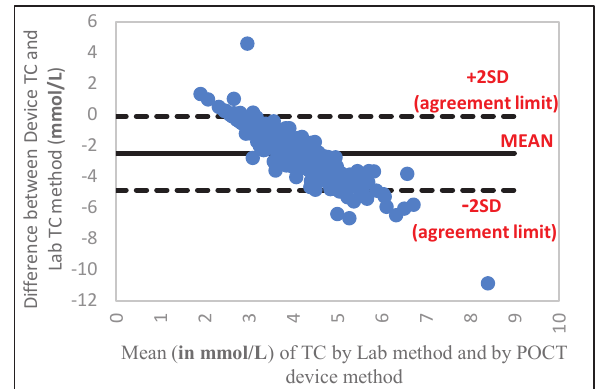
Fig-1: Bland Altman Plot for the difference between the POCT device and the laboratory for